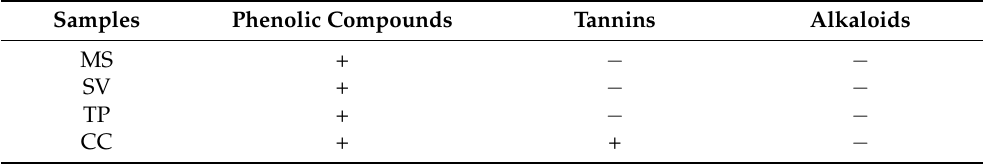
Table 1. Phytochemical screening of extracts from M. suaveolens (MS), C. canadensis (CC), S. verbenaca (SV) and T. polium